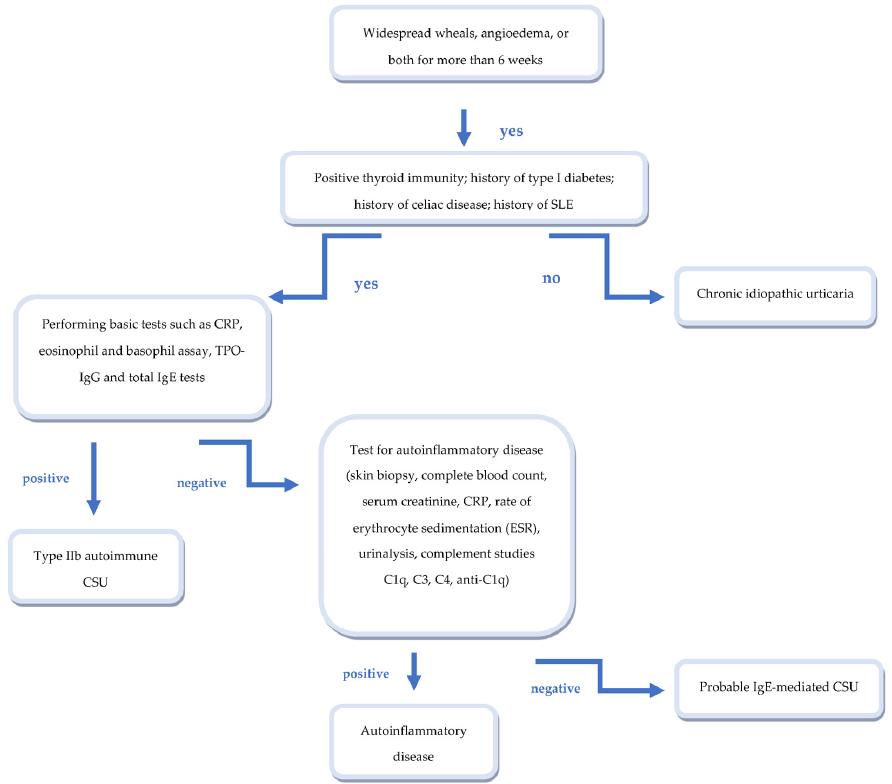
Figure 2. Algorithm for the differential diagnosis of urticarial rash .